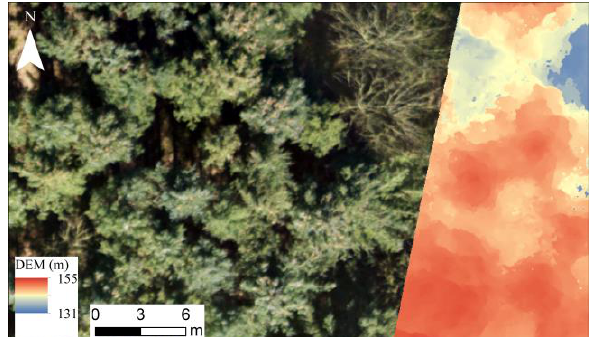
Figure 1. Orthomosaic (true-colour) and Digital Elevation Model (DEM) derived from a UAV RGB camera (details in Berra et al. (2019)), showing the fine detail (5 cm spatial resolution) that can be achieved with UAV imagery; in this case, individual trees across a Sitka spruce ( Picea sitchensis )- dominated woodland in northeast